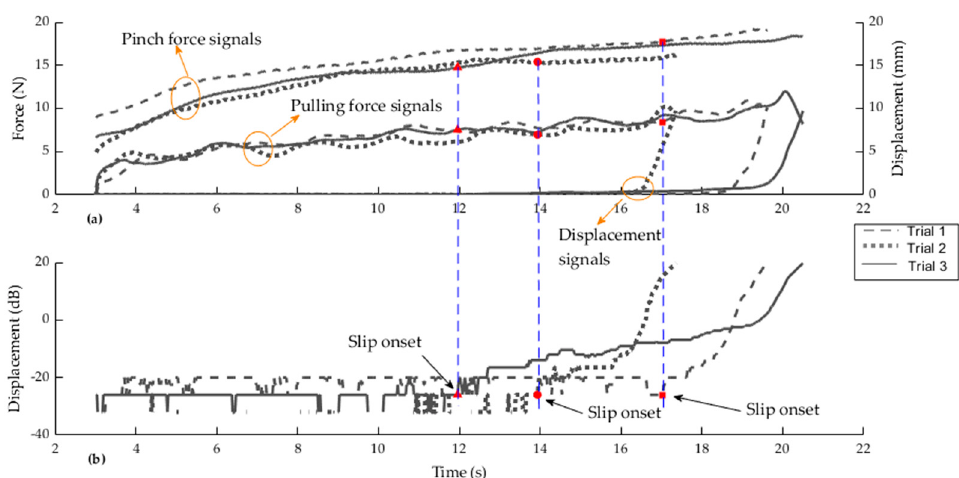
Figure A3 . ( a ) Three trials recorded from one volunteer; and ( b ) displacement i n decibel scale.